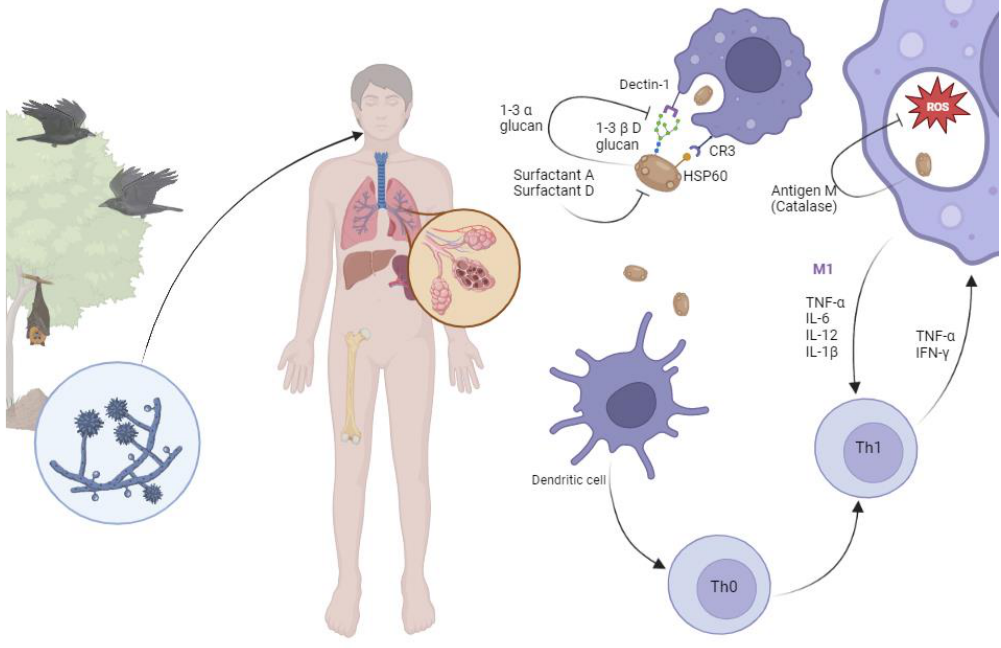
Figure 2. Pathogenesis of histoplasmosis. Aerosolized microconidia are inhaled by the host. Host temperature (37 ◦ C) triggers morphological transformation to yeast. Surfactant A and D